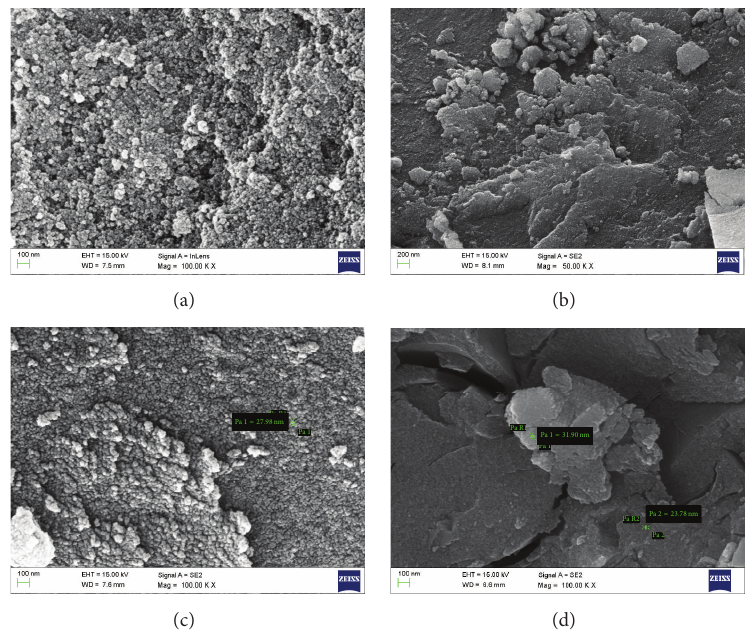
Figure 3: FE-SEM images of (a) Fe, (b) Ni, (c) Co, and (d) Cu HCF nanoparticles using Aegle marmelos.